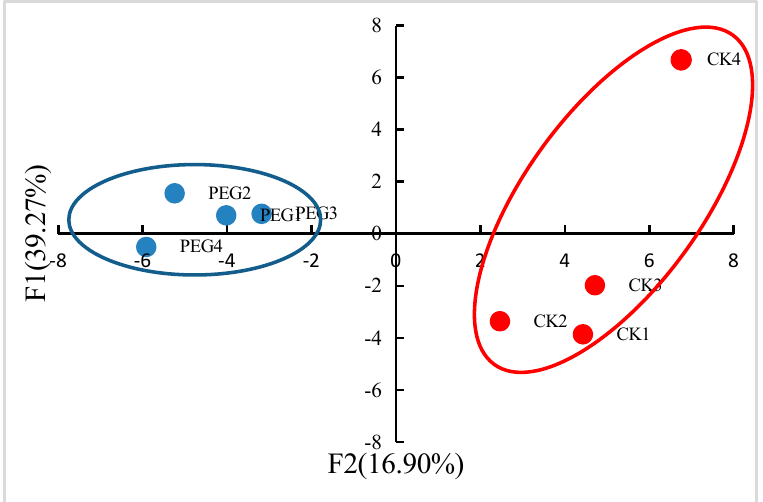
Figure 3. Principal component analysis (PCA) of wheat under drought for 4 days and controls.